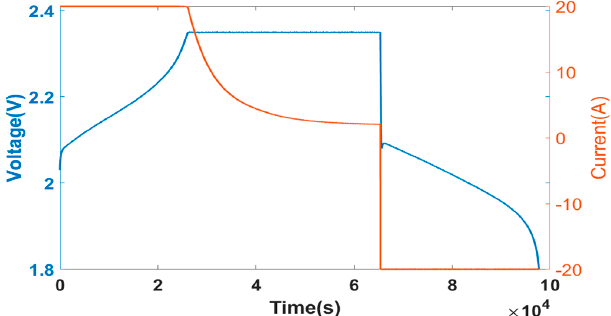
Figure 3. Charge-discharge voltage and current curve for one cycle.